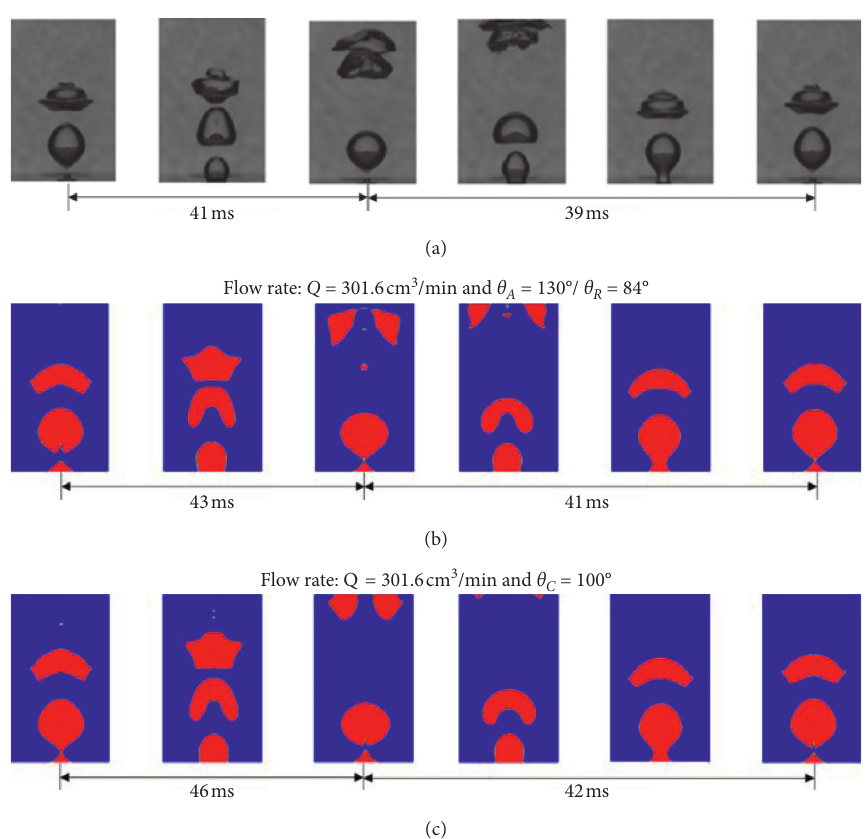
Figure 6: Snapshot comparison of bubble formation ( Q � 301.6 cm 3 /min, Re � 109.54, and d (b) results of dynamic contact angle model simulation ( θ A � 130 ° and θ R � 84 ° ); (c) results of static contact angle model simulation ( θ C � 100 °